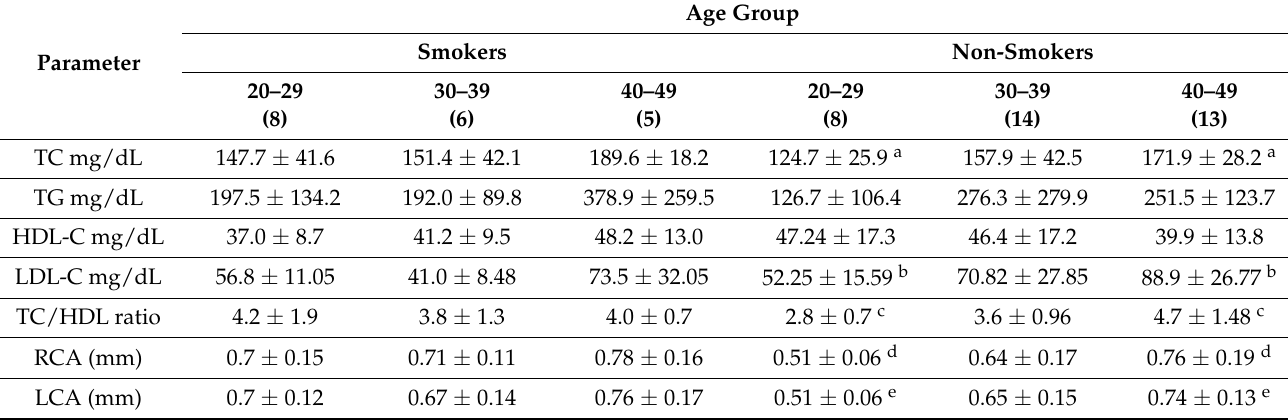
Table 4. Effect of age (years) on the calculated parameters’ mean and standard deviation for smokers and non-smokers.